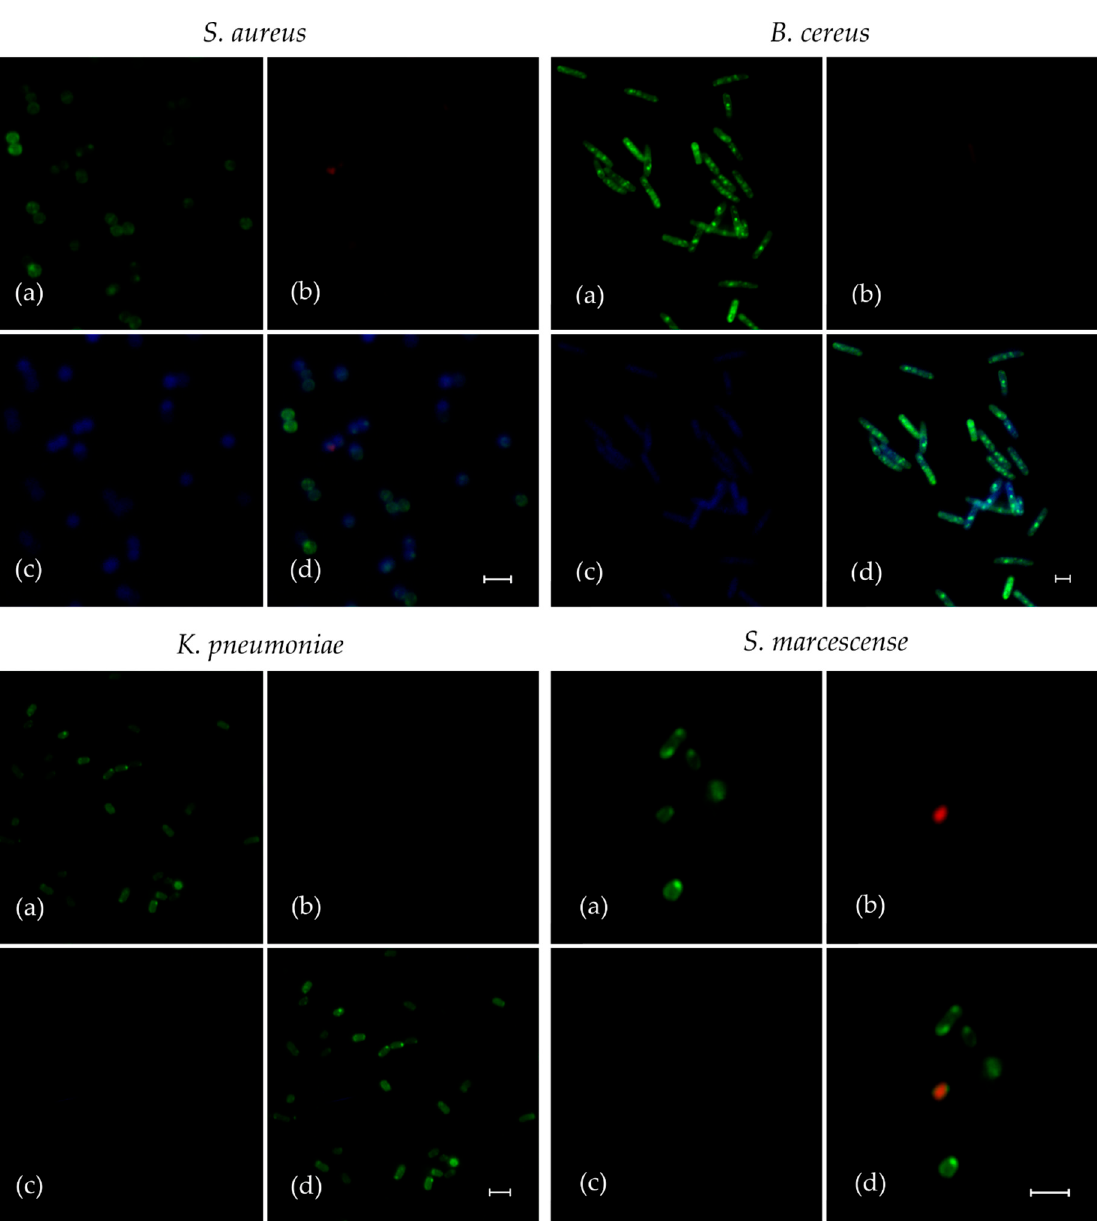
Figure 3. The analysis of fluorescent F105 analogue ( F145 ) penetration into planktonic bacterial cells. Gram-positive ( S. aureus and B. cereus ) and Gram-negative ( S. marcescens and K. pneumonia ) bacteria were grown for 24 h with agitation in MH broth, then washed and resuspended in PBS. F145 was added until the final concentration of 10 μ g/mL (close to MIC of F105 for Gram-positive bacteria), and incubation was followed for the next 15 min. Then, the cells were live/dead stained with DioC 6 /PI (additional 15 min) and analyzed with confocal laser scanning microscopy. Images show the fluorescence of DioC 6 ( a ), PI ( b ), F145 ( c ) and the combination of all channels ( d ). The scale bars indicate 2.5 μ m.